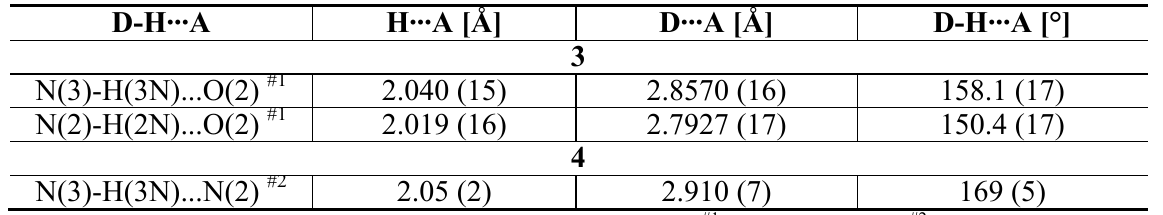
Table 2. Hydrogen-bond geometry for 3 and 4 .